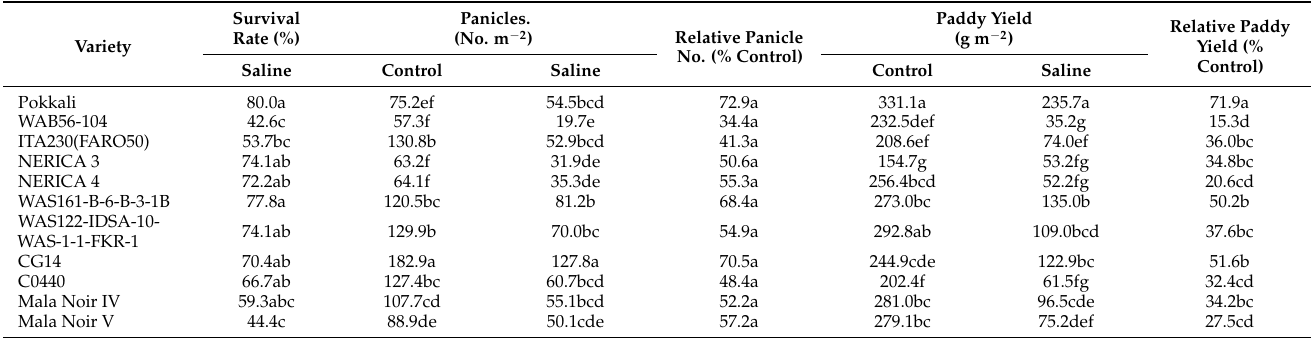
Table 4. Rice genotype survival rate, absolute and relative yield characters, in saline and control wetlands (Exp.